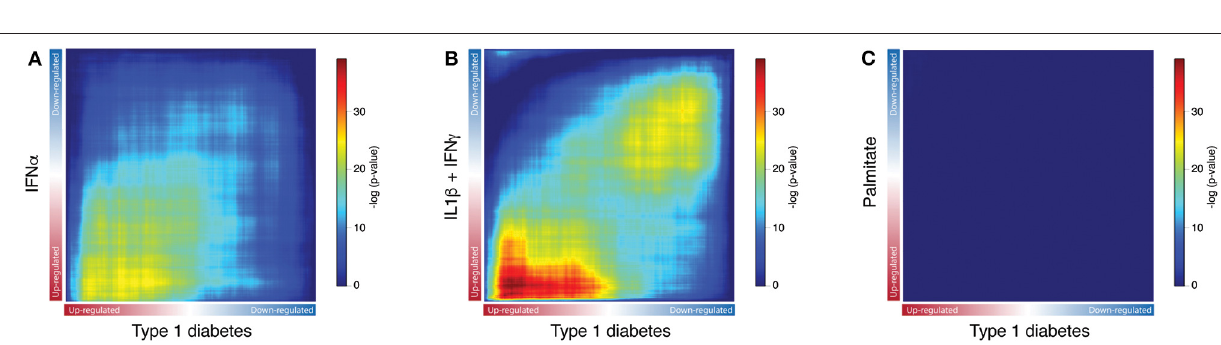
FIGURE 3 | Exposure of human islets to pro-inflammatory cytokines, but not to palmitate, induce a similar transcriptomic profile as observed in islets isolated from patients affected by type 1 diabetes. (A–C) Rank-Rank Hypergeometric Overlap (RRHO) map comparing the transcriptional expression profile of human islets exposed to IFN α ( A ), IL1 β + IFN γ ( B ) or palmitate ( C ) to the one present in primary beta cells from individuals affected by T1D, as identified by RNA-seq. Ranked lists of transcripts based on the -log 10 p -values from the differential expression analysis of human islets exposed to IFN α ( A ), IL1 β + IFN γ ( B ) or palmitate ( C ) were compared to a similarly ranked-list from beta cells obtained from patients with